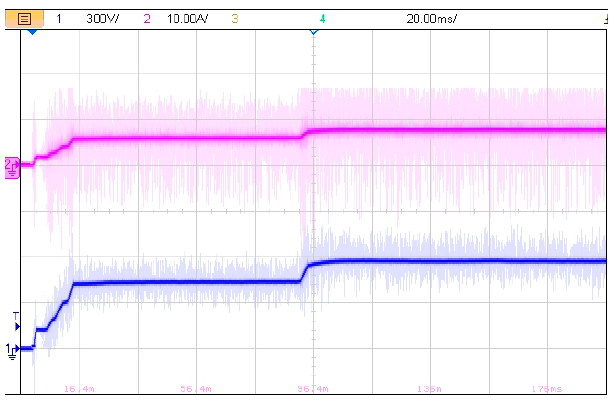
Figure 15. Output voltage V o (purple-Scale: 300 V / div) and output current I o (blue-Scale: 10 A / div). Total time: 200 ms.